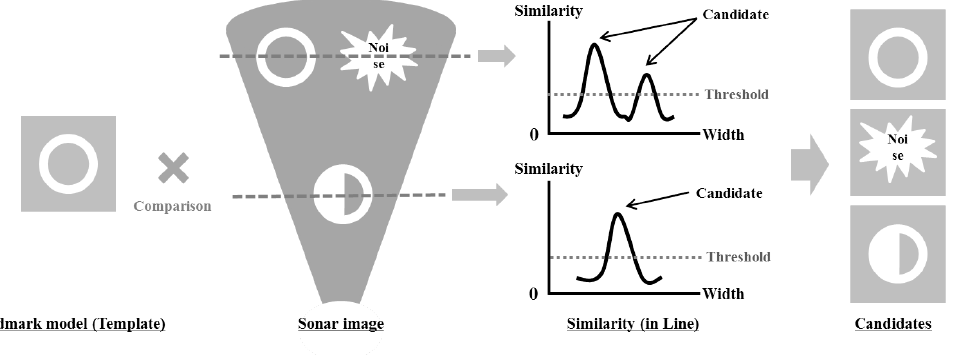
Figure 4. Process of selection of candidate: this is similar to the conventional template matching method. A landmark model is compared with the sonar image and the high similarity region is to be a candidate.